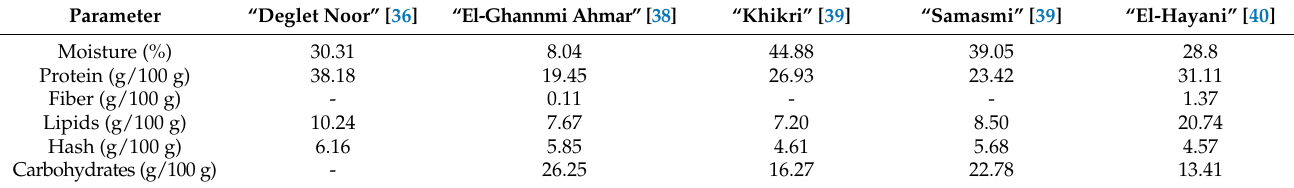
Table 1. Comparative analysis of the proximate chemical composition of five DPP sources. Parameter “Deglet Noor” [36] “El-Ghannmi Ahmar”